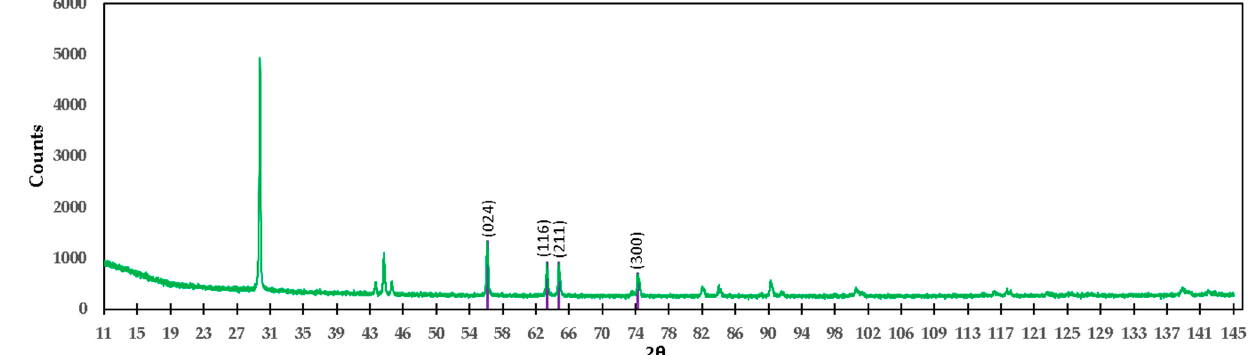
Figure 16. Diffractogram of the M3 formulation (titania of high purity), showing the identification of Ti 2 O 3 .